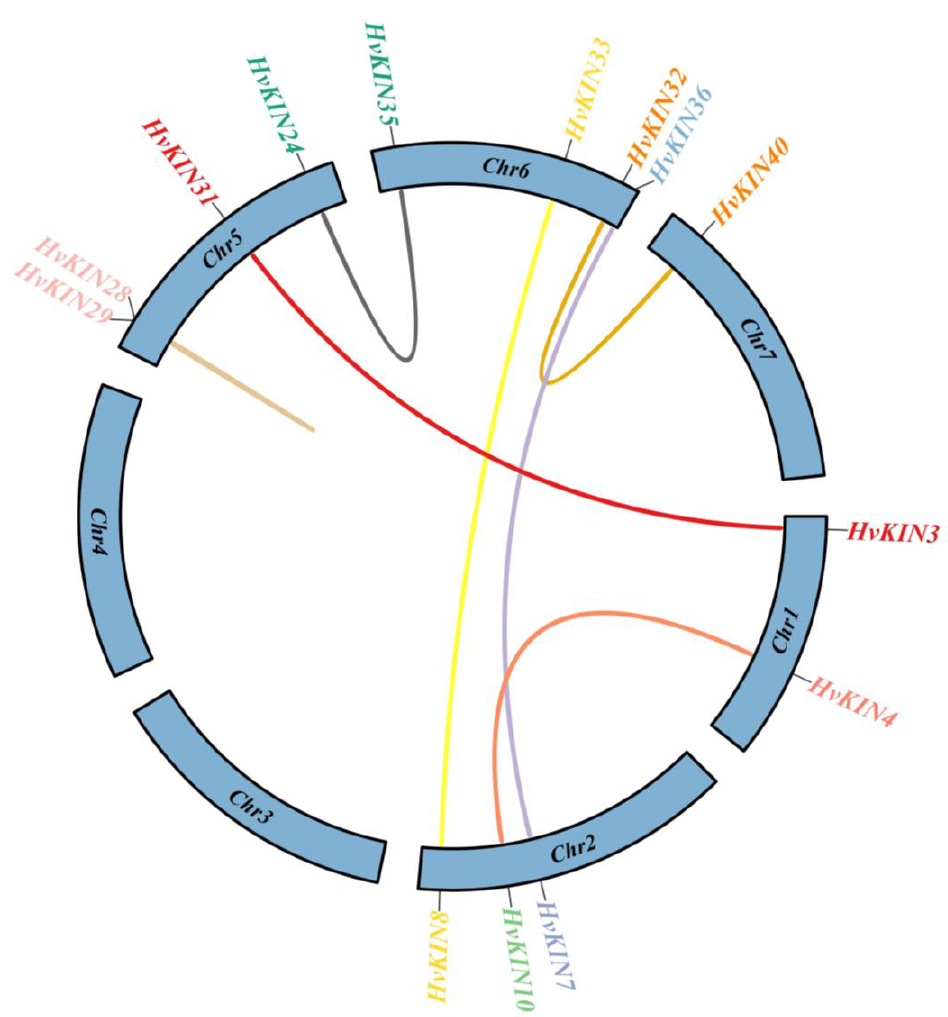
Figure 6. The members of the barley HvKIN , along with their corresponding gene pairs and chromosomal locations. Different colored lines represent the two genes’ connection in terms of replication. The name of the linked gene and its location on the chromosome are listed in the outer circle. TBtools v1.082 (South China Agricultural University, Guangzhou, China) was used to create